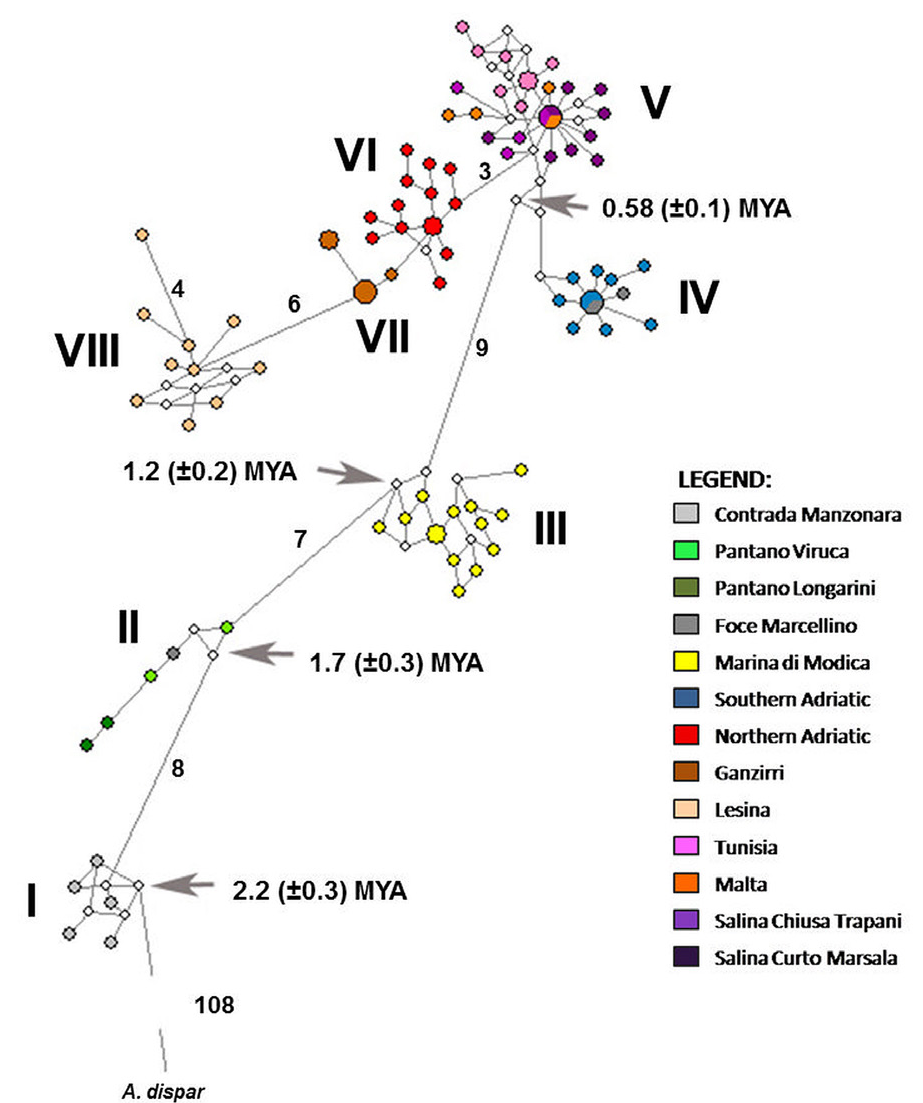
Fig. 4. – Median-joining network of mitochondrial control region haplotypes. Circle size indicates haplotype frequency, whereas branch lengths are proportional to the number of mutations. Where there are more than two mutational steps, the number of mutations is displayed along that branch. Roman numerals indicate clusters with haplotypes from Contrada Manzonara (ITA) (I); Pantano Viruca, Pantano Longarini and Foce Marcellino (ITA) (II); Marina di Modica (ITA) (III); Ston (CRO), Ulcinj (MNE), Narta (ALB) (e.g. Southern Adriatic group) and Foce Marcellino (ITA) (IV); Salina Curto Marsala, Salina Chiusa Trapani (ITA), Malta and Tunisia (V); Se č ovlje (SLO), Nin, Pag, Dinjiška and Pantan (CRO) (e.g. Northern Adriatic group) (VI); Ganzirri (ITA) (VII); and Lesina (ITA) (VIII). Numbers by arrows represent estimated divergence time of population or